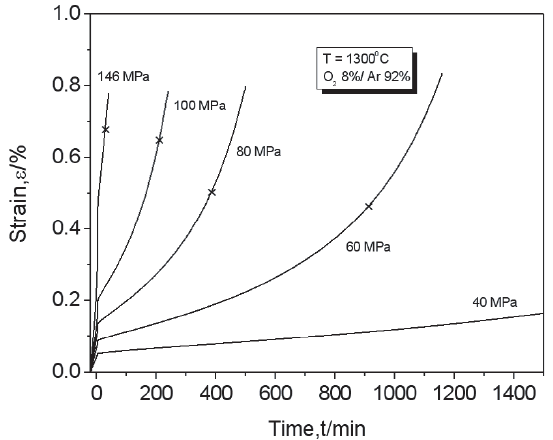
Fig. 5. Oxidation-assisted strain evolutions for a C/SiC com- posite at 40, 60, 80, 100, and 146